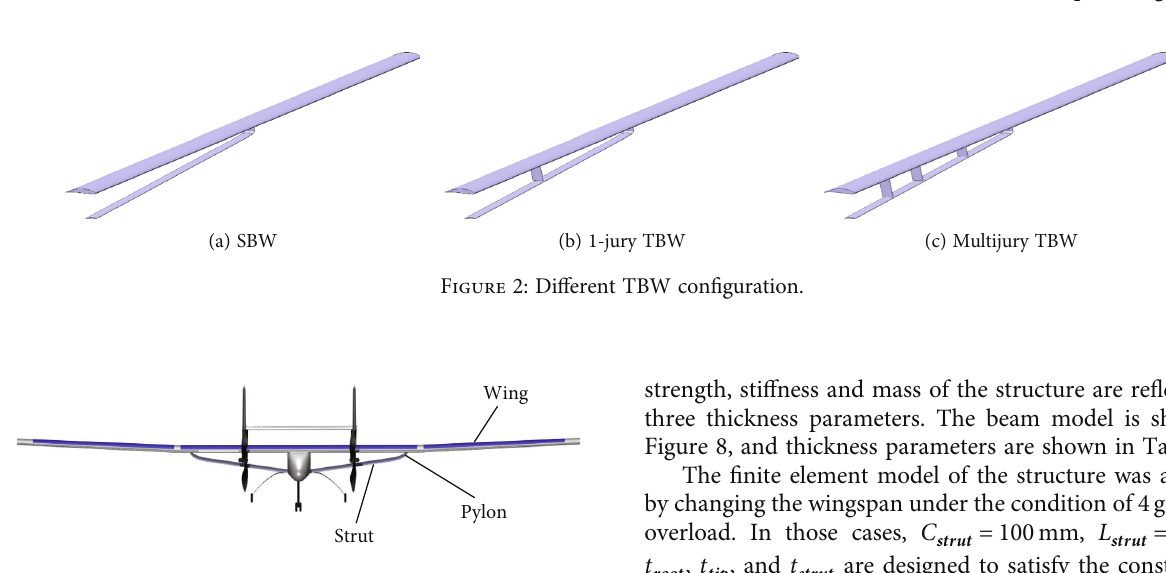
Figure 3: Hybrid energy UAV with SBW con fi guration. Table 2: Aerodynamic design